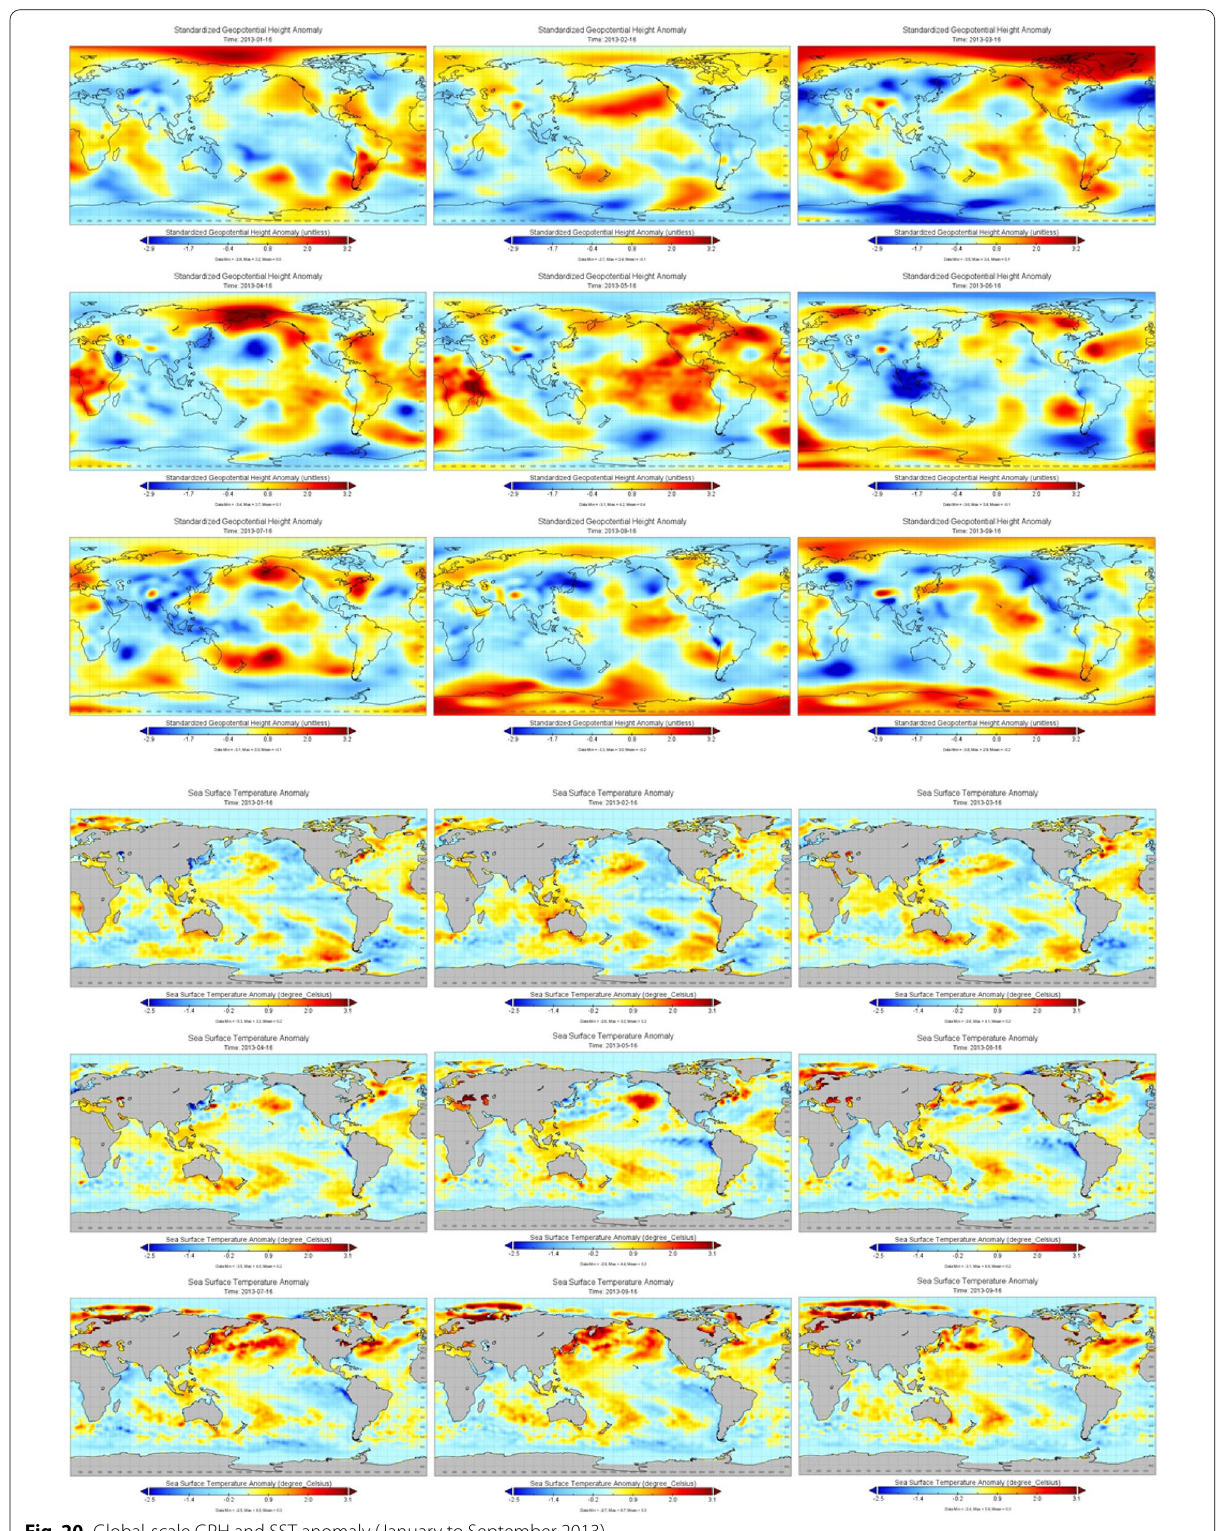
Fig. 20 Global-scale GPH and SST anomaly (January to September